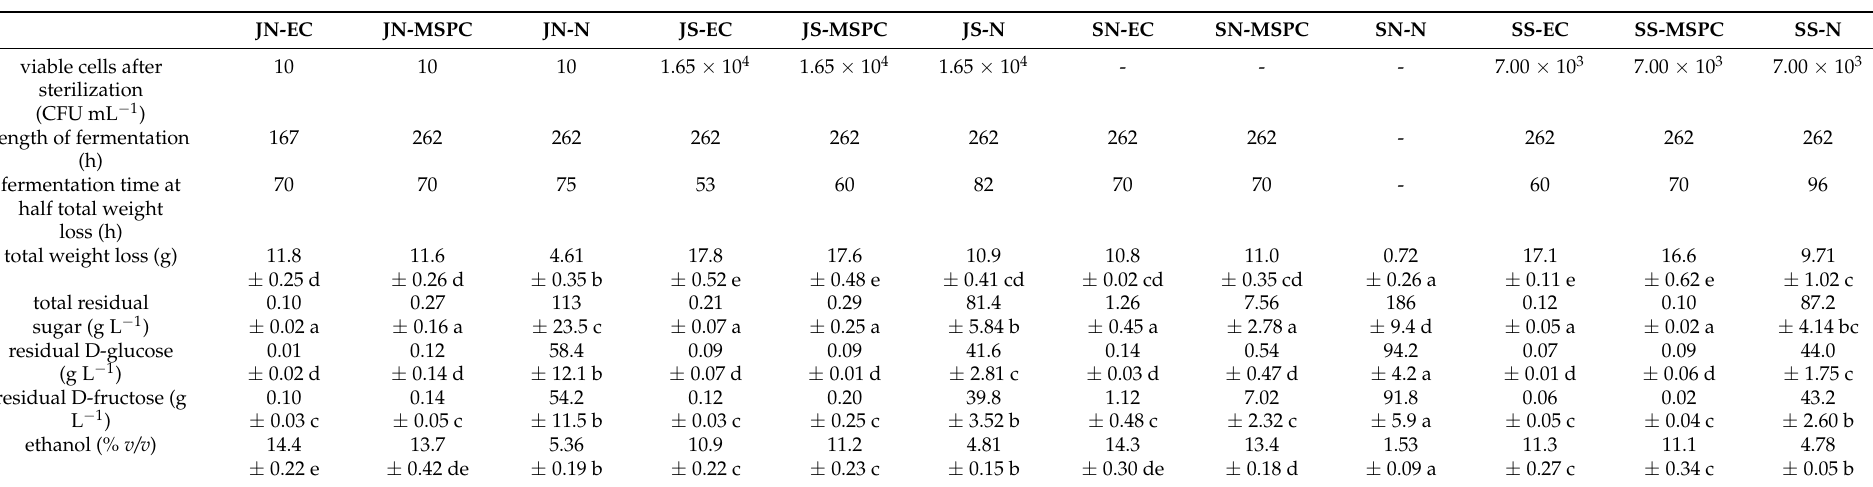
Table 2. Sterilization efficacy, fermentation duration, total weight loss, ethanol, and residual sugar concentrations of finished wines for each treatment. Mean (n = 3) ± standard deviation. Mean values not connected by the same letter are significantly different (Tukey’s HSD, p < 0.05). Juice no skins (JN); juice plus skins (JS); SGM no skins (SN); SGM plus skins (SS); EC1118